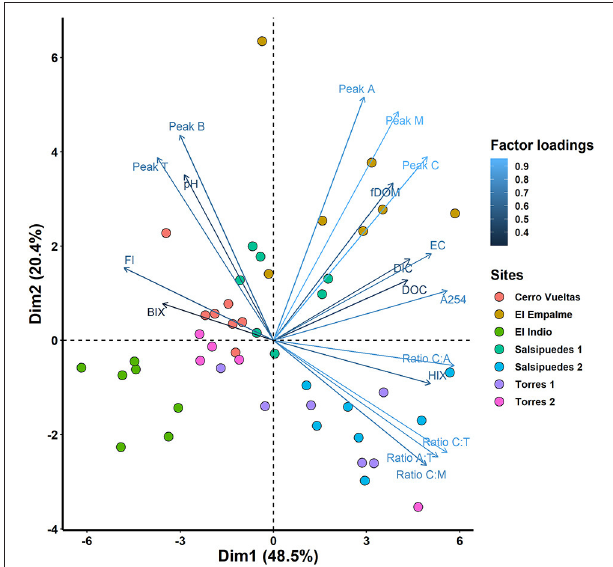
FIGURE 8 | Principal component analysis biplot explaining 68.9% of the total variance in two dimensions, including individual variable factor loadings (blue color scale) and distribution between the sampling sites (color-coded dots). El Empalme and El Indio represent the lowest and highest sampling sites, respectively (see Figure 1